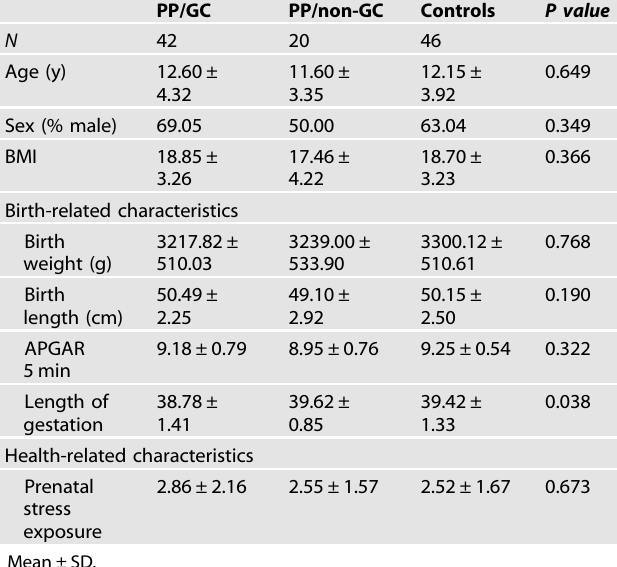
Table 1. Sample characteristics ( N =